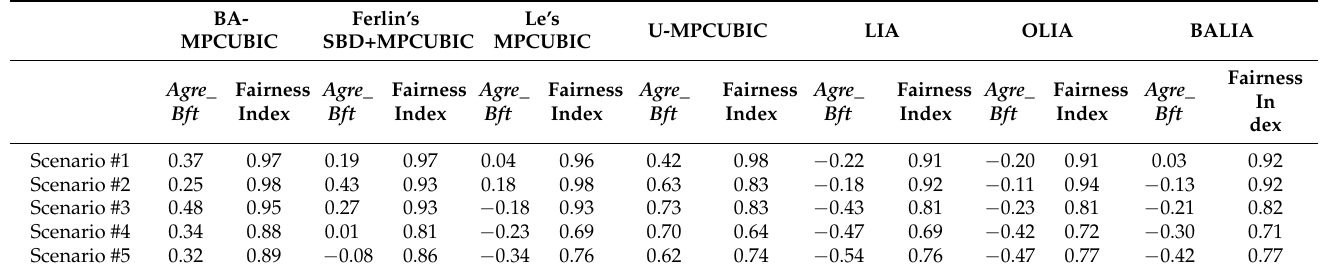
Table 1. Performance comparison in terms of overall Agre _ Bft and fairness index in Scenarios #1–5.